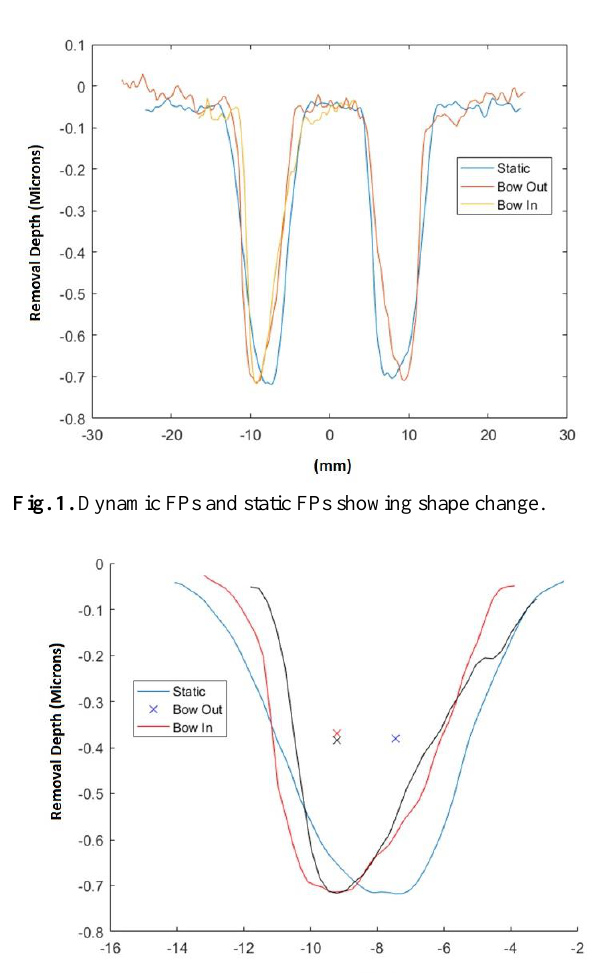
Fig. 2. FWHM analysis of FPs